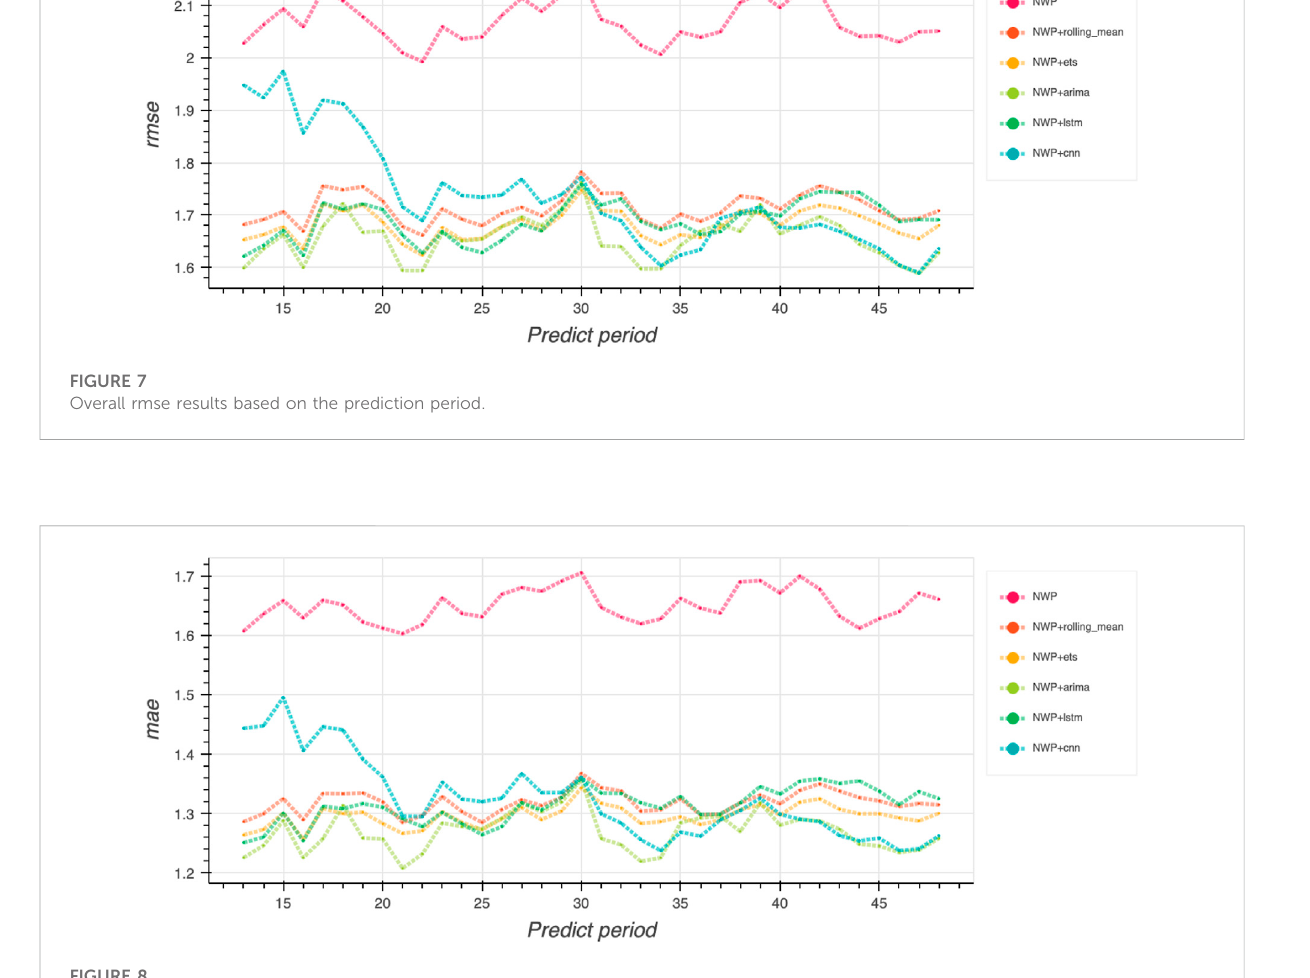
FIGURE 8 Overall mae results based on the prediction